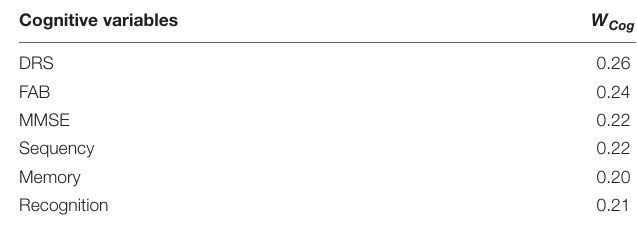
estimate for Figure 1 : paths a and b) between Neuroepo dosage and latent cognitive variable. Estimates for the direct and indirect path are calculated via the mediation package (Tingley et al., 2019) in R with 1000 Monte-Carlo simulations.